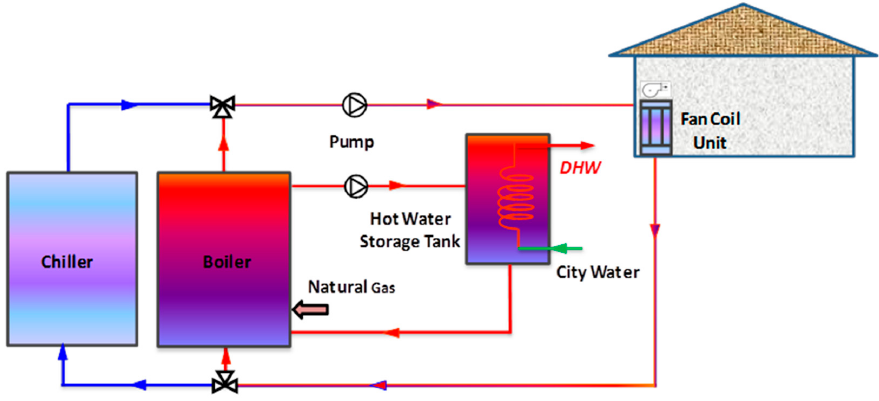
Figure 1. Schematic diagram of conventional system (Case 1).